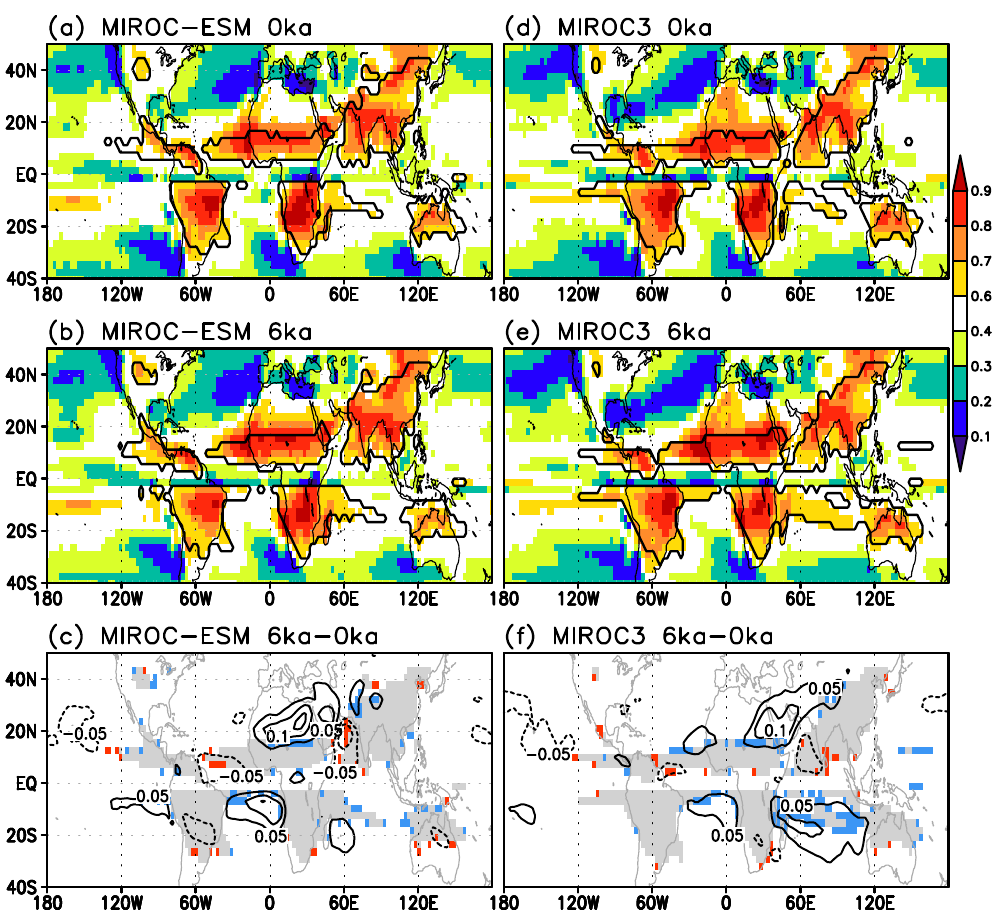
Fig. 11. Global monsoon precipitation domain (contour) and MPI (shading) for the 0ka (top panels) and 6ka (middle panels) climates obtained using MIROC-ESM (left panels) and MIROC3 (right panels). In (c, f) for the change in the monsoon domain, the grey areas indicate the regions identified in common, and the blue (red) area indicates the area of expansion (retreat) in the 6ka simulations. The contours denote the 6–0ka MPI